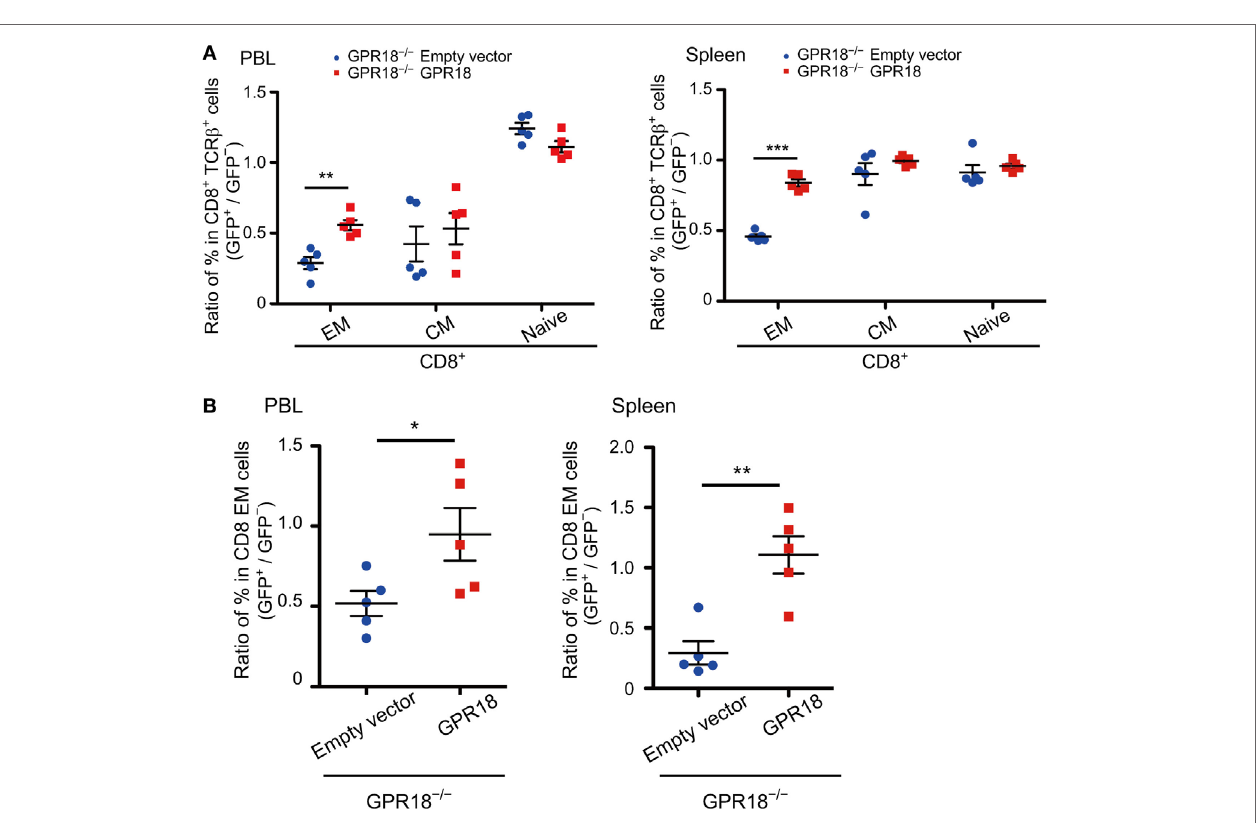
FigUre 5 | Rescue effects of G-protein-coupled receptor 18 (GPR18) expression on CD8 effector memory (EM) cells in Gpr18 − / − mice. (a,B) CD45.2 + Gpr18 − / − bone marrow transduced with empty vector or Gpr18 retrovirus was used to reconstitute CD45.1 + recipients ( n = 5). Donor cells were gated on CD45.1 − CD45.2 + and then gated on GFP + (transduced donor cells) or GFP − (untransduced donor cells). (a) CD8 + TCR β + cells from peripheral blood lymphocytes (PBL) (left panel) or spleen (right panel) were stained for naïve (CD44 lo CD62L hi ), EM (CD44 hi CD62L lo ), and CM (CD44 hi CD62L hi ). Percentage of EM, CM, and naïve populations in GFP + donor cells were presented as a ratio to those in GFP − donor cells from the same animal. (B) CD8 EM cells from PBL (left panel) or spleen (right panel) were stained for KLRG1. Percentage of KLRG1 + populations in GFP + donor cells were presented as a ratio to those in GFP − donor cells from the same animal. Each symbol represents an individual mouse, and lines represent means ± SEM. *** p < 0.001, ** p < 0.01, * p < 0.05 by Student’s t -test.